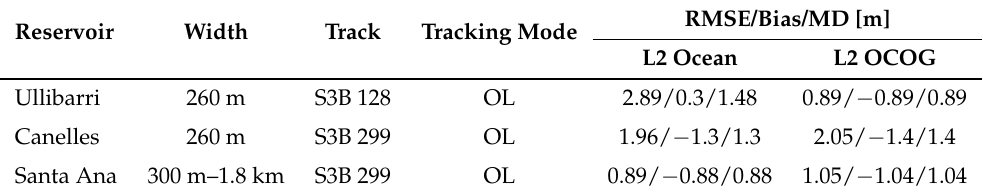
Table 6. Results of the S3B water level comparison with in situ data (December 2018–December 2019).